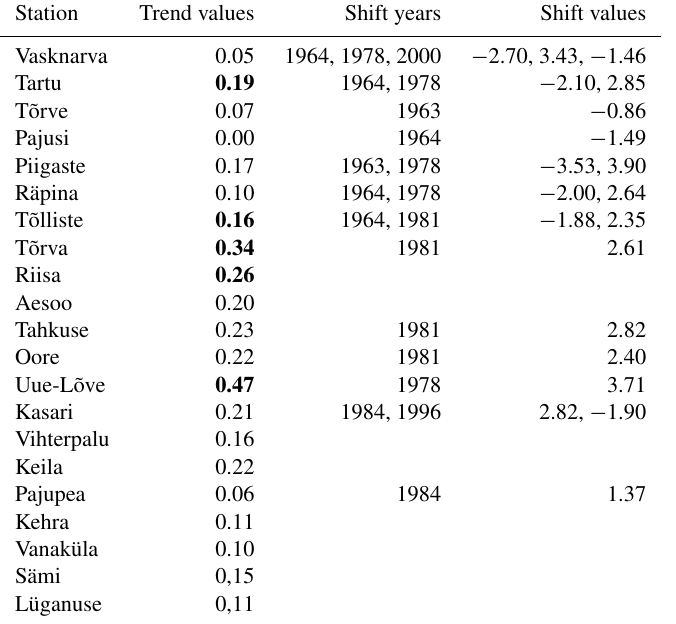
Table 6. Trend values, years of regime shifts and corresponding shift values of annual mean specific runoff. Statistically significant trends on p <0.05 are in